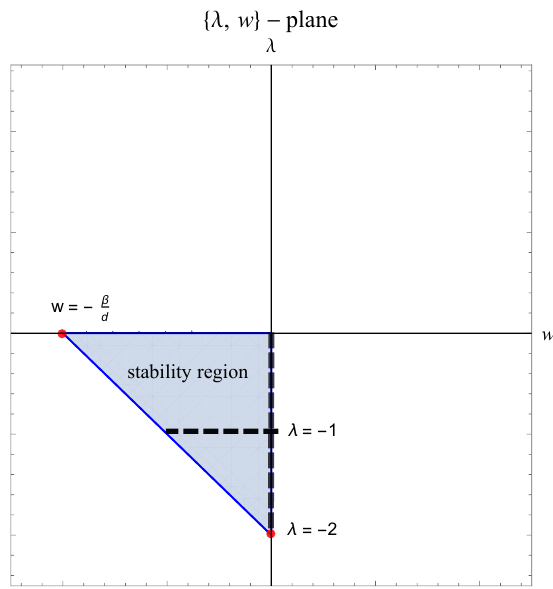
Figure 1 . The shaded region indicates where the solutions are stable despite the properties of the function F . For w = 0 or λ = − 1, in general the stability is contingent on the sign of F 00 ( H 0 ), represented by the dashed line on these boundaries, while the case { w, λ } = { 0 , − 2 } is stable as long as ˙Φ < 0 and it can be grouped together with the class ˙Φ = − βH for β >